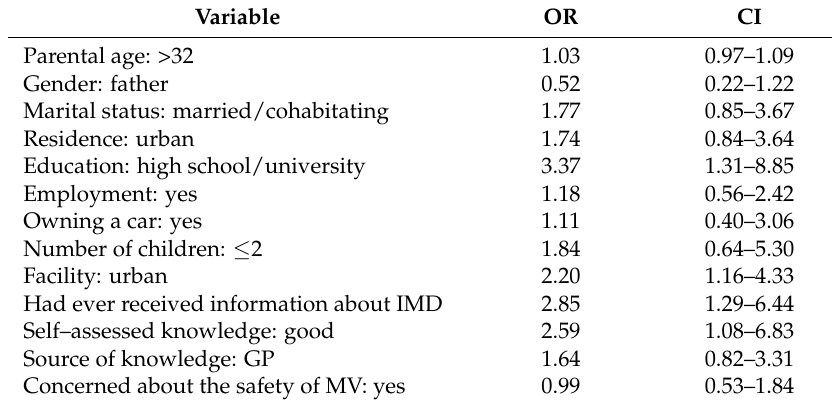
Table 4. Logistic regression model: association of the knowledge level about meningococci with selected variables (odds ratio (OR) estimates and 95% confidence intervals (CIs) of OR estimates); Poland, 2018; n =